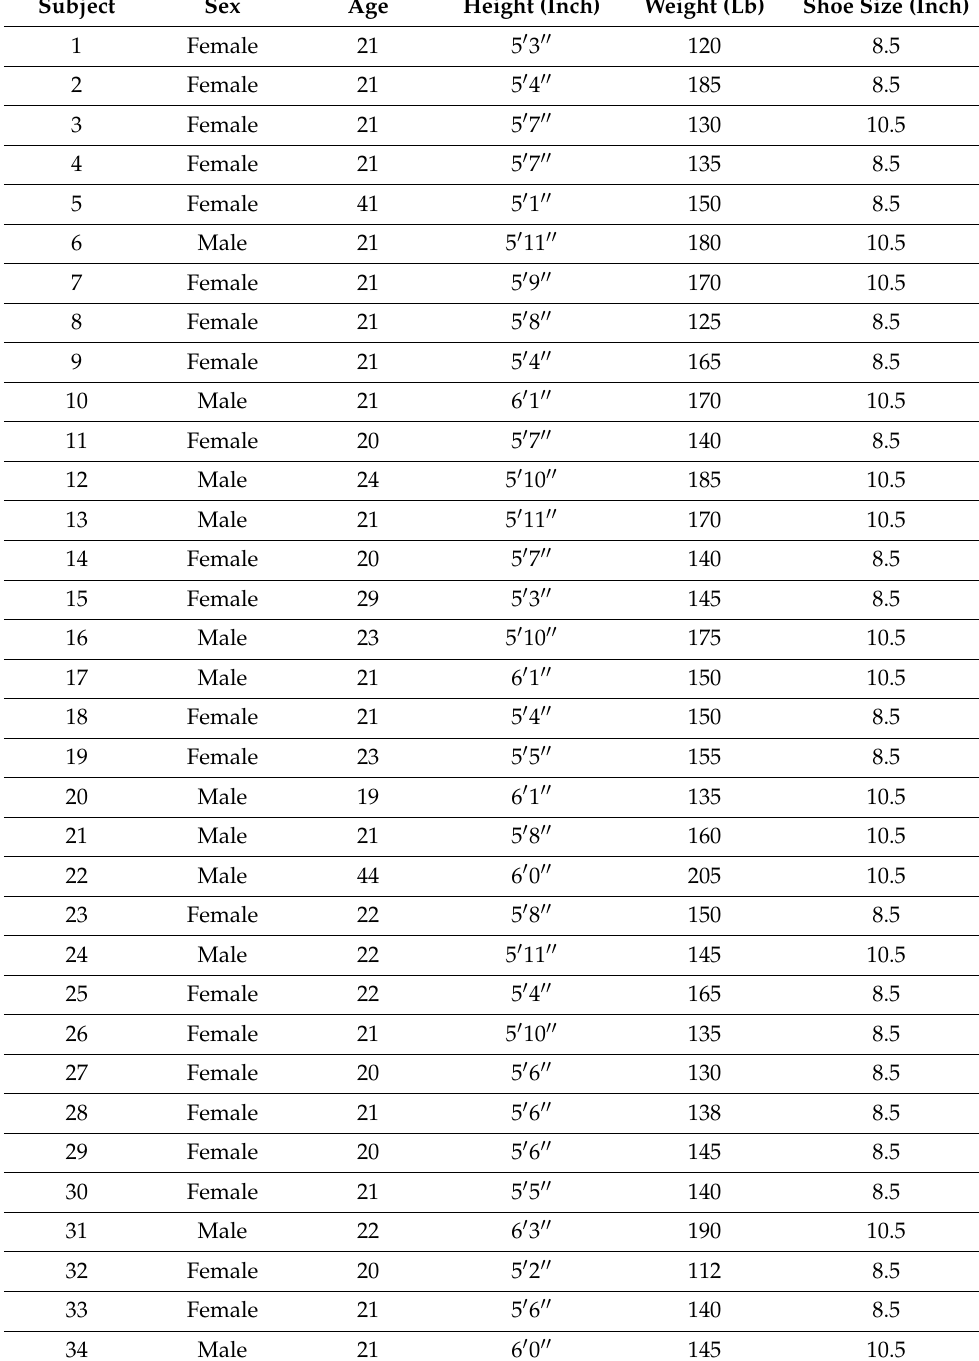
Table 3. Participant’s